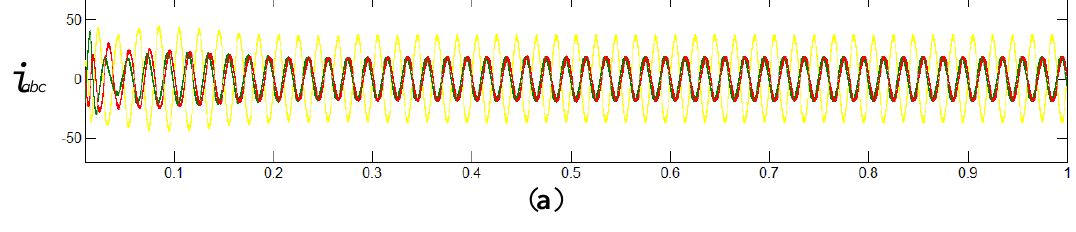
Figure 6. Diagram of simulation of the DC-link voltage control: ( a ) unbalance current of DC/AC circuits; ( b ) DC link voltage and UC current under control scheme (1); ( c ) DC link voltage and UC current under control scheme (2); ( d ) DC link voltage and UC current under control scheme (3); ( e ) DC link voltage and UC current under control scheme